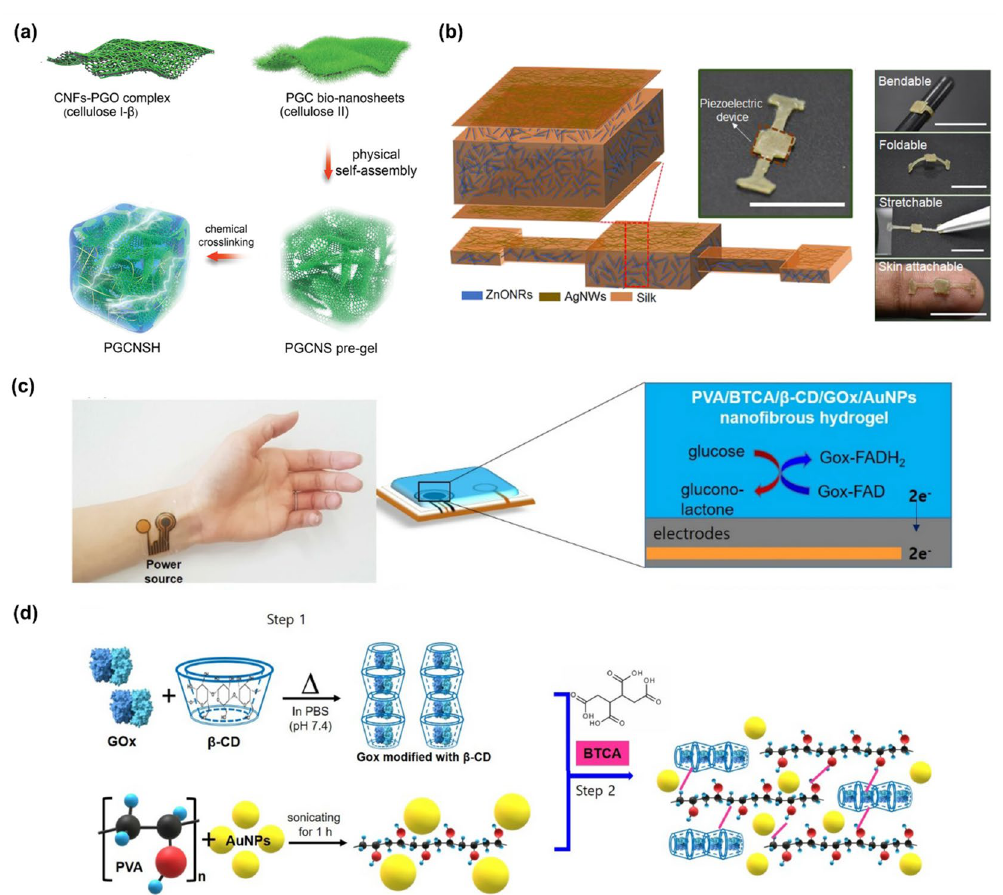
Fig. 4 a Schematic image for the development process of pure regenerated cellulose‑based hydrogel (PGC bionanosheet‑assembled hydrogel (PGCNSH)) via chemical crosslinking of a (PGO)‑hybridized cellulose bionanosheet (PGCNS) by using ECH. Reproduced with permission from [70], copyright John Wiley and Sons, 2021. b Scheme and optical images of artificial electronic skin composed of engineered silk protein hydrogel, ZnO NRs, and Ag NWs, and its flexibility and adhesion properties. Reproduced with permission from [77], copyright Elsevier, 2020. c Optical image and